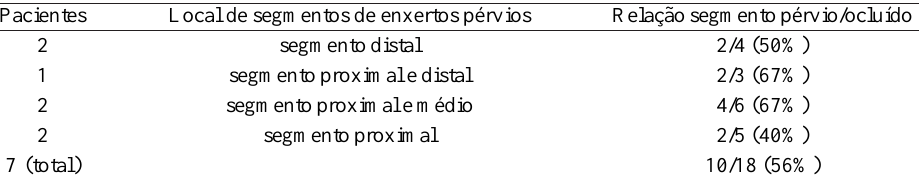
Tabela 2. Ponte safena com falência parcial: segmentos pérvios dos